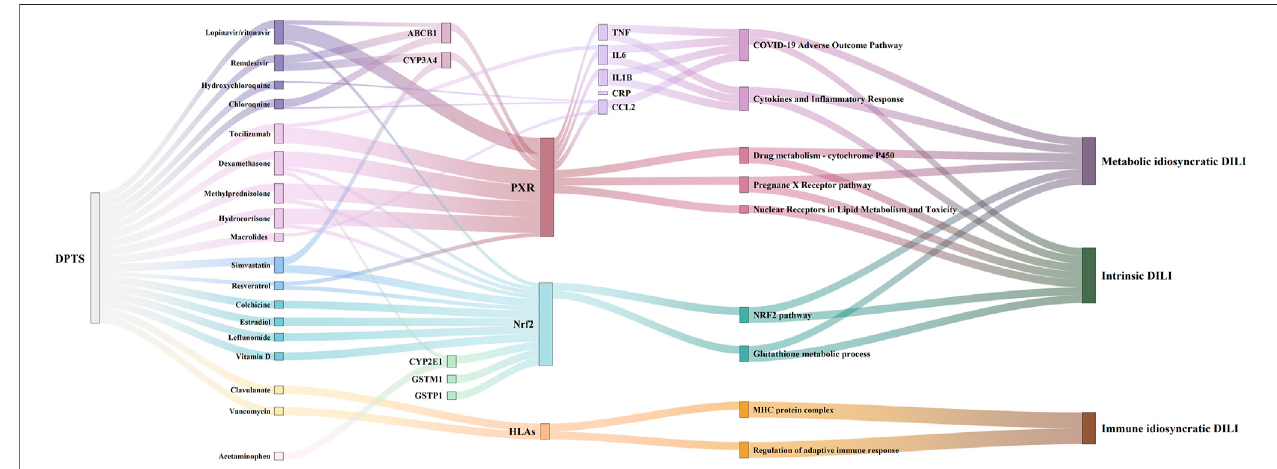
FIGURE 6 | Potential mechanism underlying the DPTS-induced liver